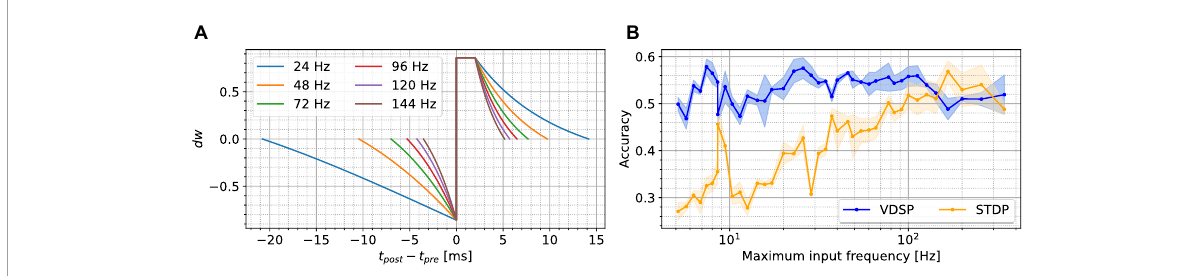
FIGURE4 Presynaptic firing frequency dependence of VDSP and STDP. Subfigure (A) shows the effect of scaling the presynaptic neuron input current on the VDSP update window for fixed weight w = 0 . 5 in a two neurons configuration. As the input current changes, the presynaptic neuron fires at various frequencies indicated by the line color. Higher presynaptic spiking frequencies result in smaller time windows. The plateau between (cid:49) t ∈ [ 0 , 2 ] ms is an artifact of the refractory period of 2 ms, where the membrane potential is kept at a reset value throughout. In (B) , similar scaling is applied to the values of the pixels being fed to the presynaptic neurons during the MNIST classification task using the WTA architecture. Each point in (B) results from running the task 5 times with different random seeds using 10 output neurons, with standard deviation shown with the light-colored area under the curve. No adaptation mechanism was used for (B) to provide an unbiased comparison between classical STDP and VDSP in different spiking frequency regimes. No frequency-specific optimization was done during these experiments.